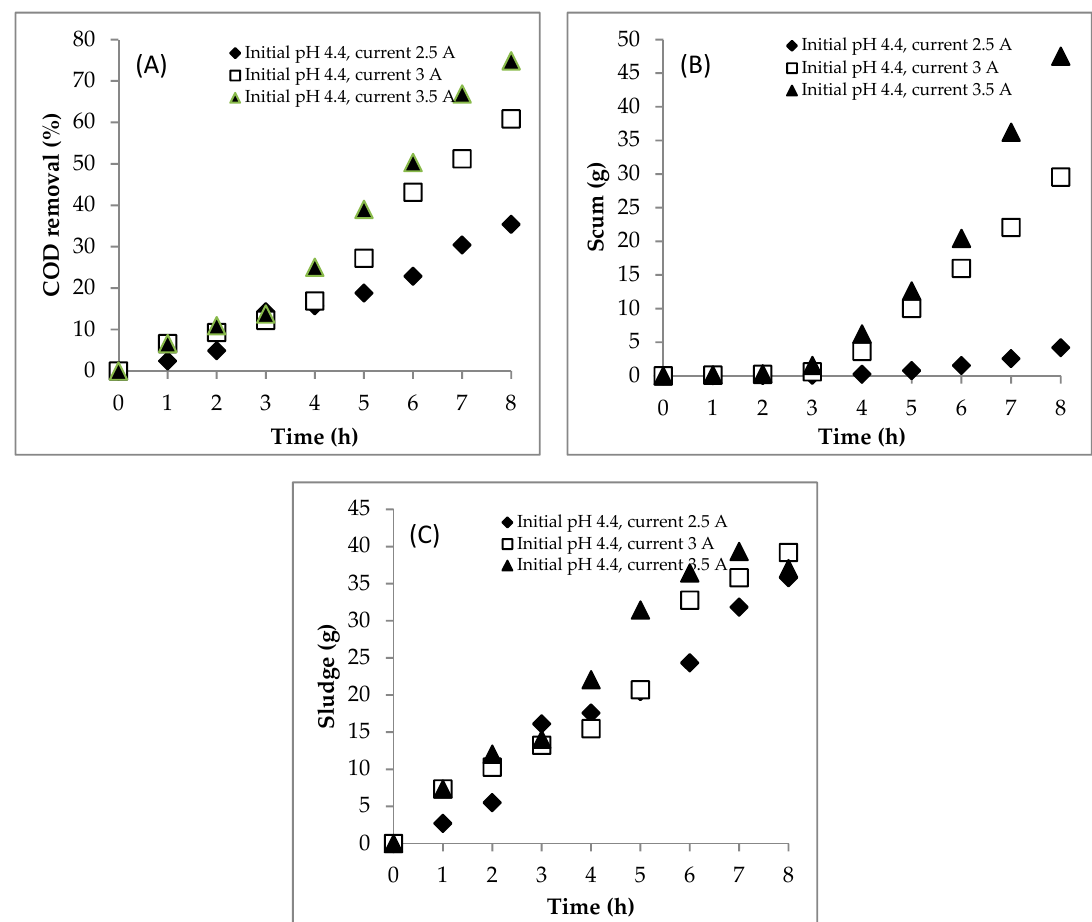
Figure 2. Effect of the current on ( A ) COD removal, ( B ) scum production and ( C ) sludge production during the EC process. Initial COD of 112,948.5 mgL − 1 ; initial pH of 4.4; initial temperature of 27 °C.